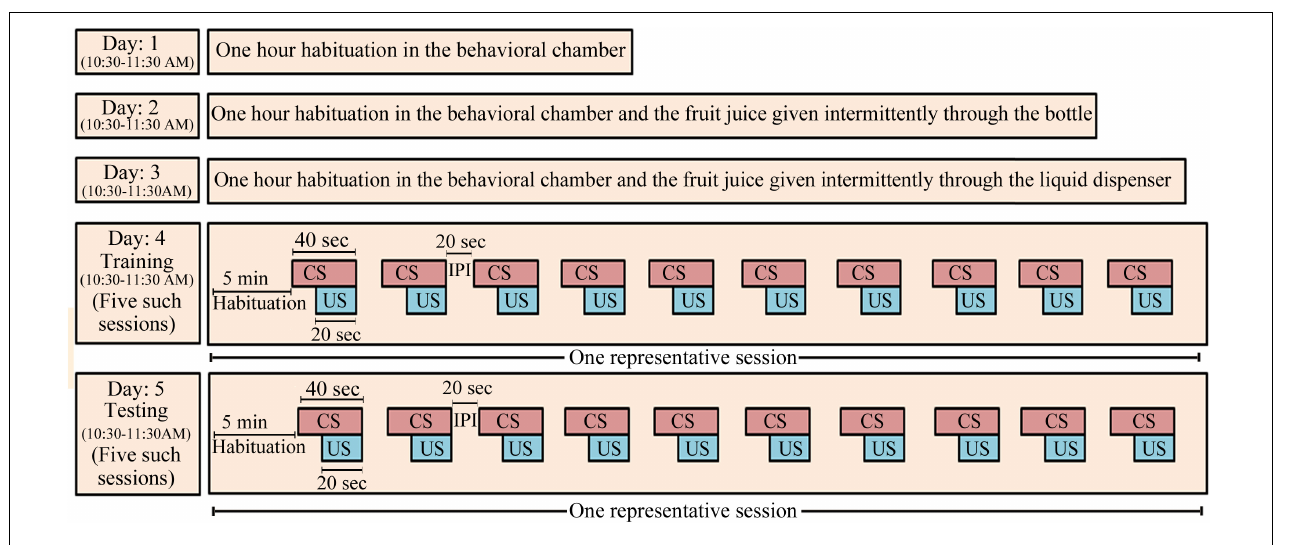
FIGURE 1 | The appetitive-conditioning protocol: Rats were first habituated to the experimental condition on three consecutive days daily for 1 h (10:30–11:30 AM). On day 1, the animals were habituated to the conditioning chamber for 1 h. On day 2, the animals were again habituated to the conditioning chamber for 1 h, but mango fruit juice was given manually through a small bottle intermittently during habituation. It was done so that the animals develop a taste for the juice. On day 3, the mango juice was given to the animal for about 15–20 times through the liquid dispenser of the juice-dispensing unit during the habituation. The experimenter manually operated the juice-dispensing unit and guided the animal toward the juice-dispensing window. Training and testing of the appetitive-conditioned task were performed on subsequent days. House light in the behavior chamber was used as a conditioned stimulus, and fruit juice was used as unconditioned stimulus. CS, conditioned stimulus; US, unconditioned stimulus; IPI, inter-presentation